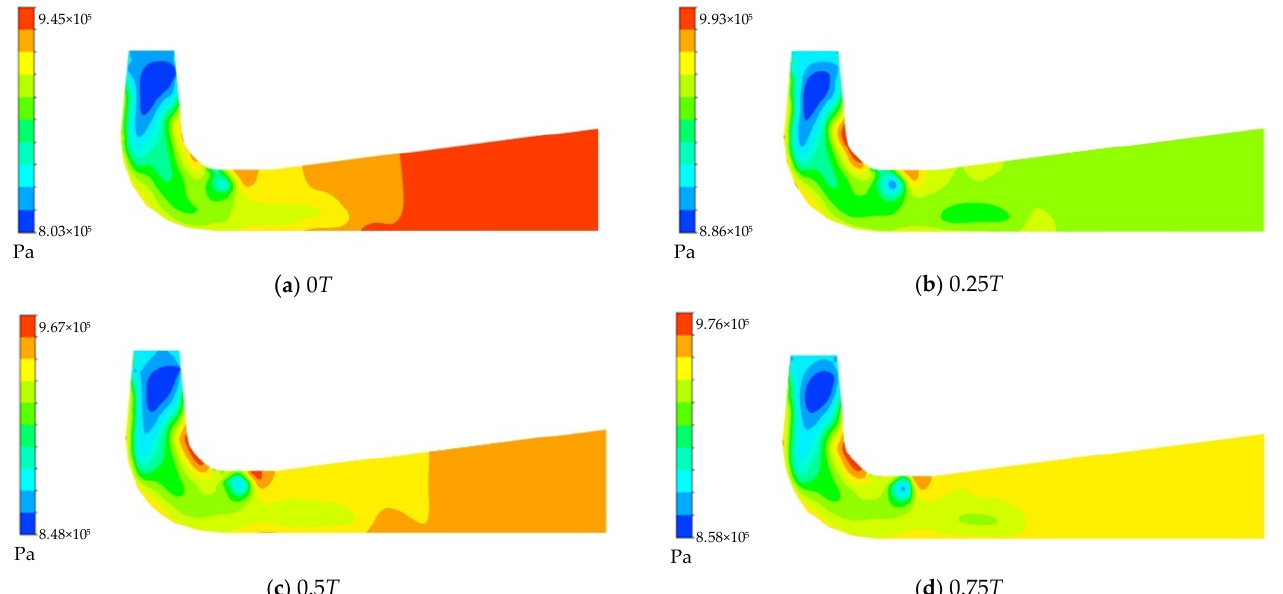
Figure 4. Pressure distribution in the middle section of draft tube.